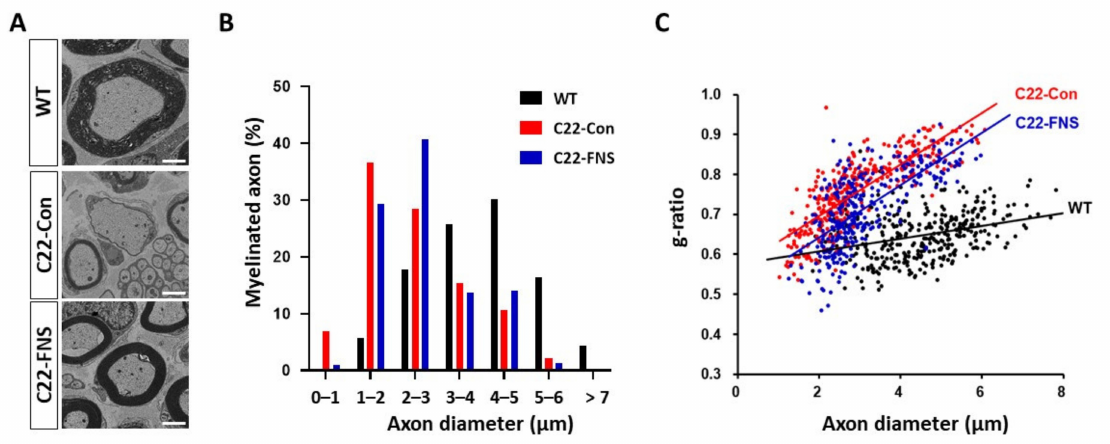
Figure 4. Farnesol improves myelination in sciatic nerves of C22 mice. ( A ) Electron microscopic images of the sciatic nerve. Scale bar, 2 µ m. ( B ) Distribution of myelinated axon diameters. Three hundred and twenty to three hundred and fifty axons from 3 mice in each group were counted. ( C ) g-ratio of myelinated axon. WT, wild-type mice; C22-Con, control diet fed C22 mice; C22-FNS, farnesol diet fed C22